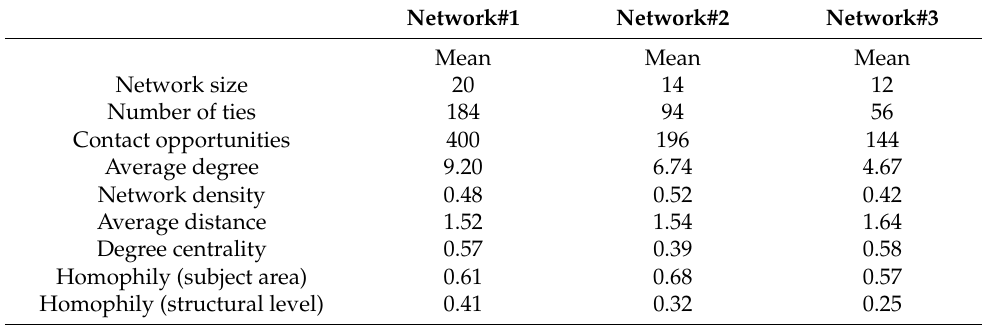
Table 2. Summary of network